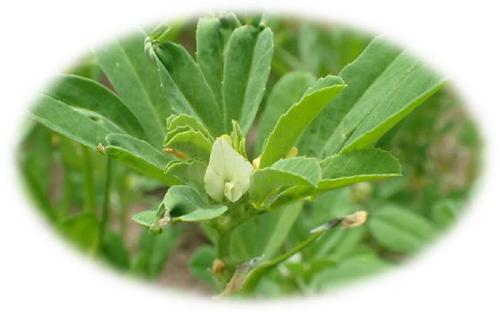
Fig. 24 Seed gums of Trigonella foenum-graecum as coagulant